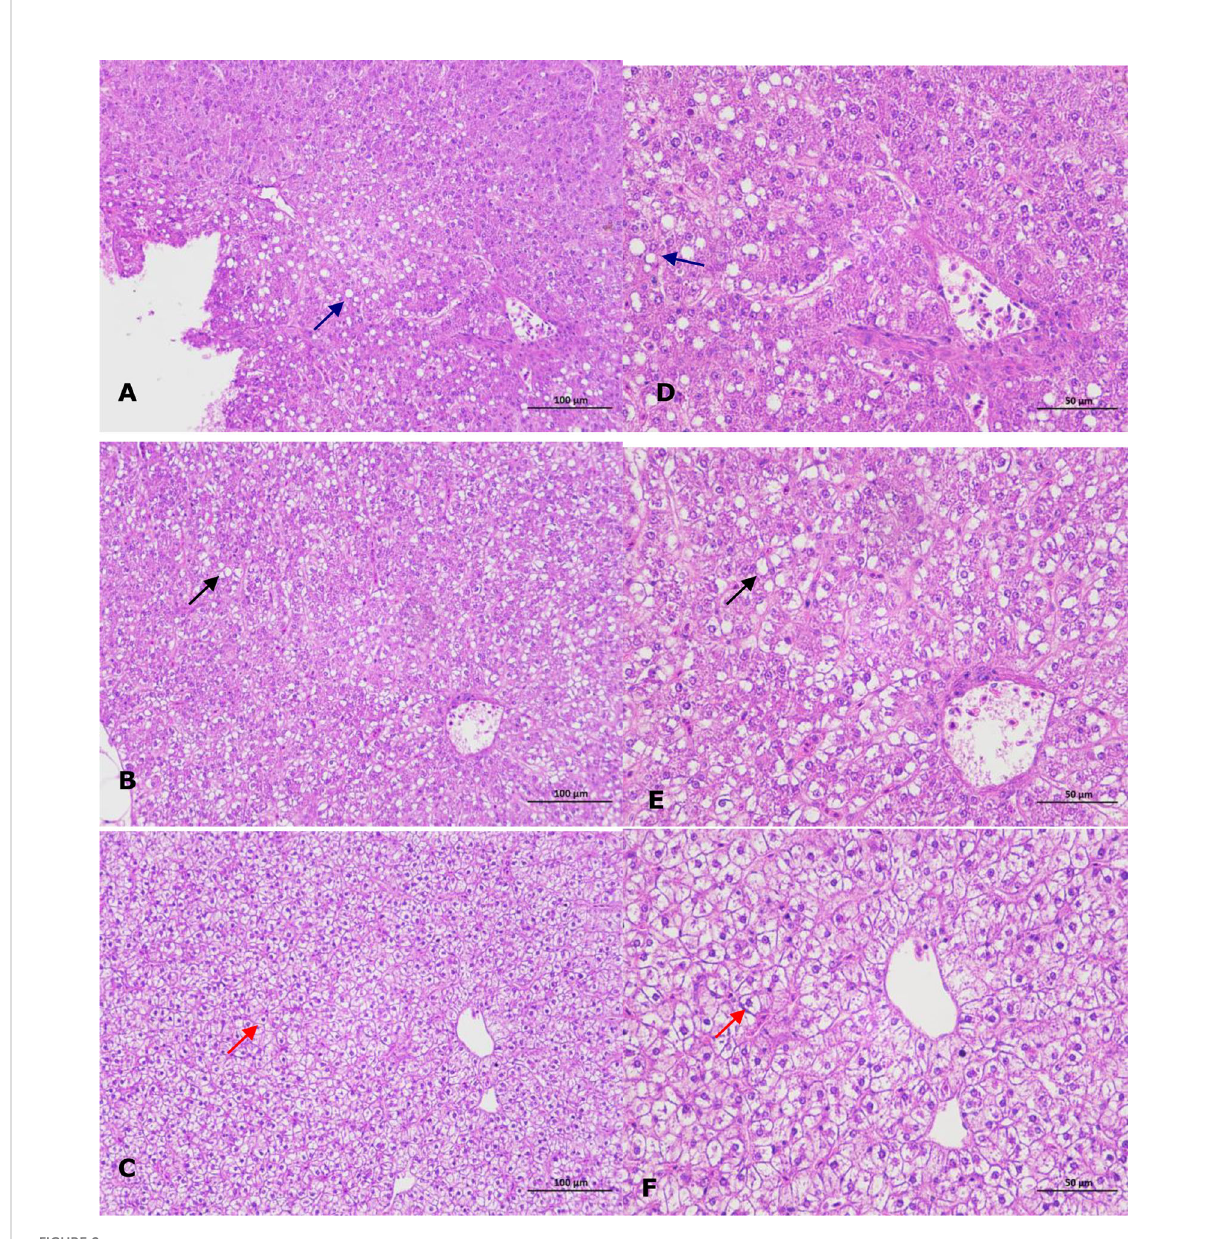
FIGURE 2 Histopathological changes in the liver of infected coral trout. (A) Vacuolar degeneration of liver cells (blue arrow) in the arti fi cially infected fi sh (×200). (B) Vacuolar degeneration of liver cells (black arrow) in the naturally infected fi sh (×200). (C) Normal liver cells (red arrow) in healthy fi sh (×200). (D) Vacuolar degeneration of liver cells (blue arrow) in the arti fi cially infected fi sh (×400). (E) Vacuolar degeneration of liver cells (black arrow) in the naturally infected fi sh (×400). (F) Normal liver cells (red arrow) in healthy fi sh